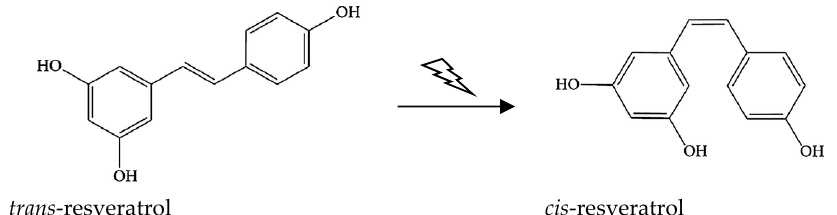
Figure 1. Conversion of trans - to cis -resveratrol after exposure to ultraviolet radiation .